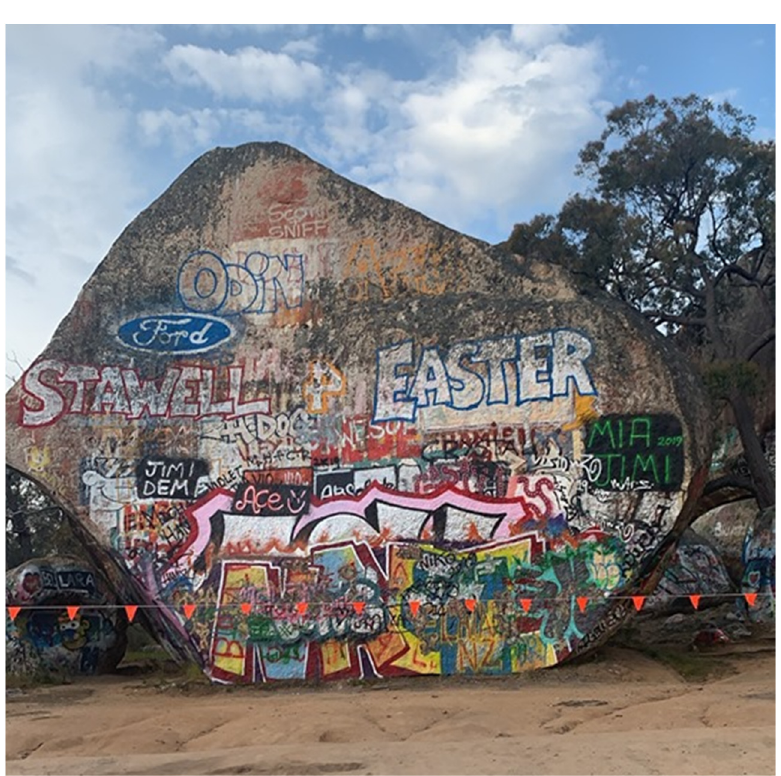
Figure 1. Sisters Rocks, near Stawell, 2019. (One Facebook comment on this photo reads ‘That fence will keep the colonials